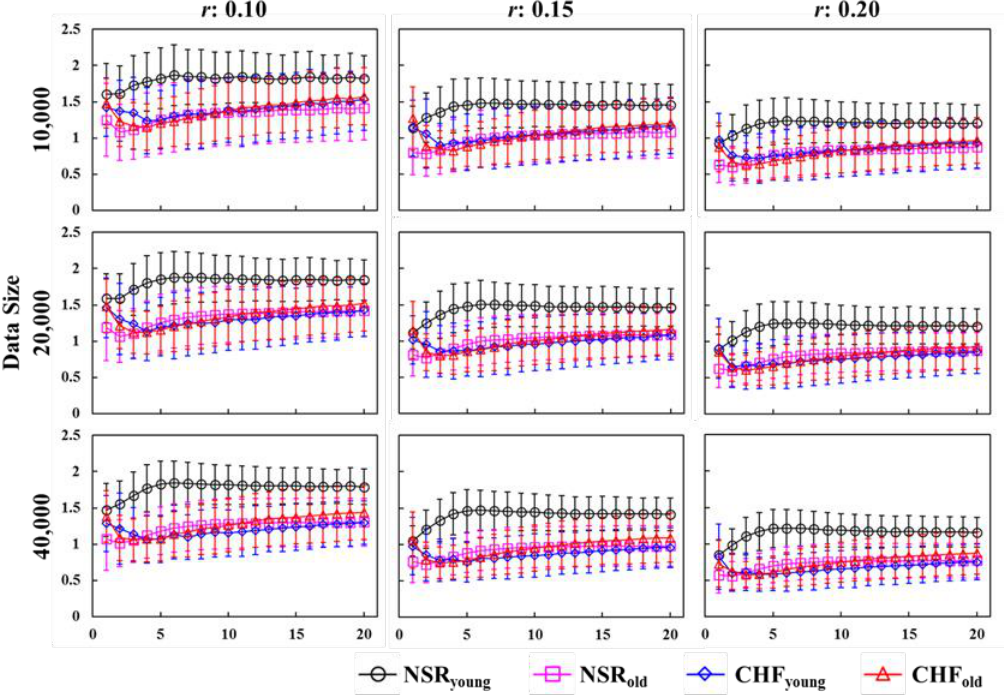
Figure 2. Multiscale entropy analysis (scales from 1 to 20) of NN interval time series from the young normal sinus rhythm (NSR) group (NSR young ; black circles), old NSR group (NSR old ; purple squares), young congestive heart failure (CHF) group (CHF young ; blue diamonds), and old CHF group (CHF old ; red triangles). Error bars represent standard deviations.